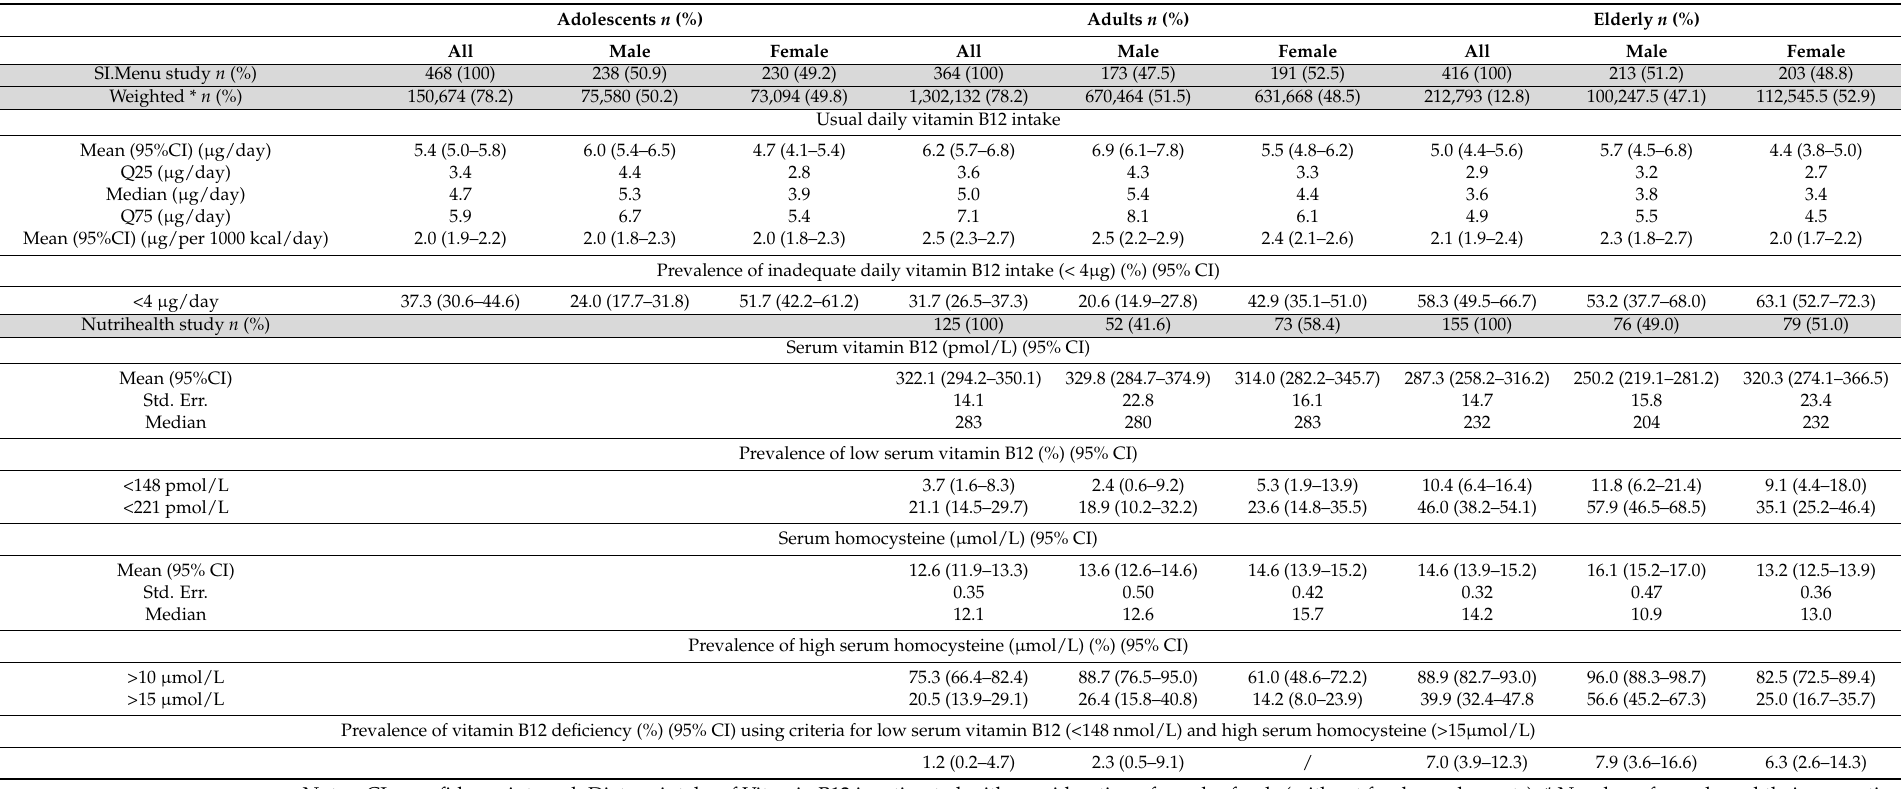
Table 2. Population-weighted usual daily vitamin B12 intake and prevalence of inadequate vitamin B12 intake (<4 µ g/day) and serum markers for